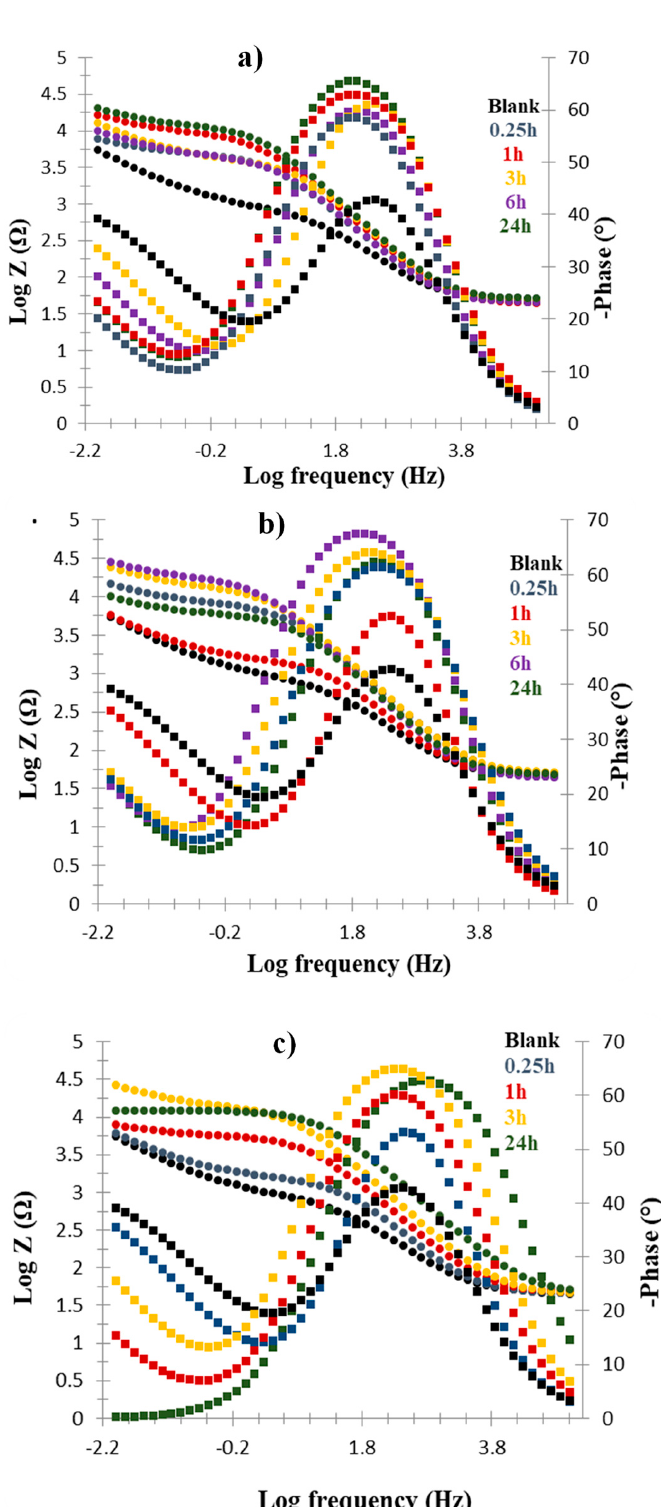
different immersion times.